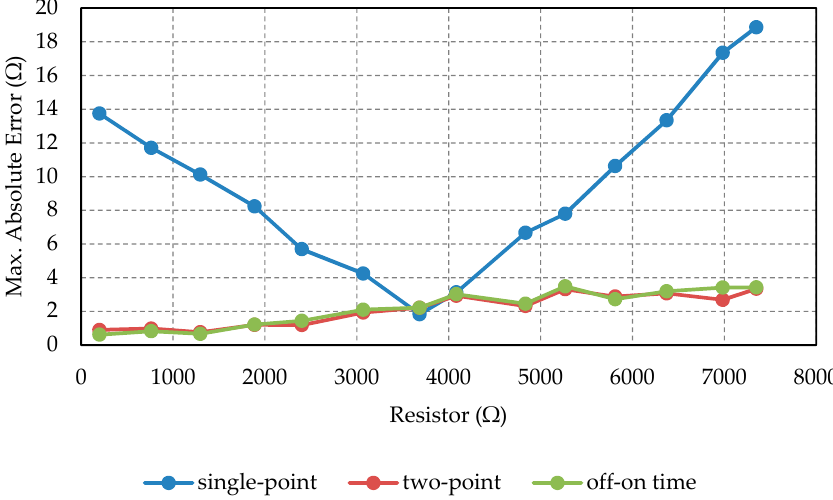
Figure 6. Worst absolute error for each resistor and calibration method.